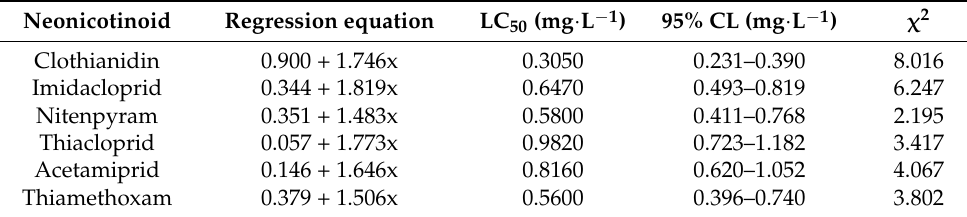
Table 2. Toxicity of each neonicotinoid insecticide against wheat aphid infestation based on the leaf-dip method after 48 h treatment.